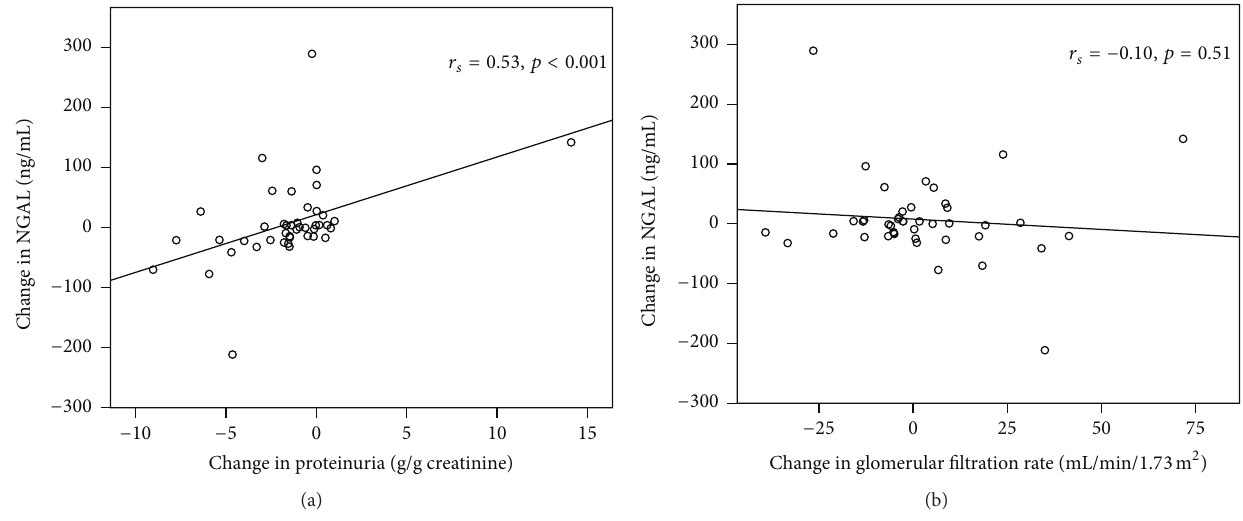
Figure 2: Relationship between change in NGAL and change in other laboratory parameters. (a) Change in proteinuria and (b) change in glomerular filtration rate ( 𝑛 = 43 ) from baseline to